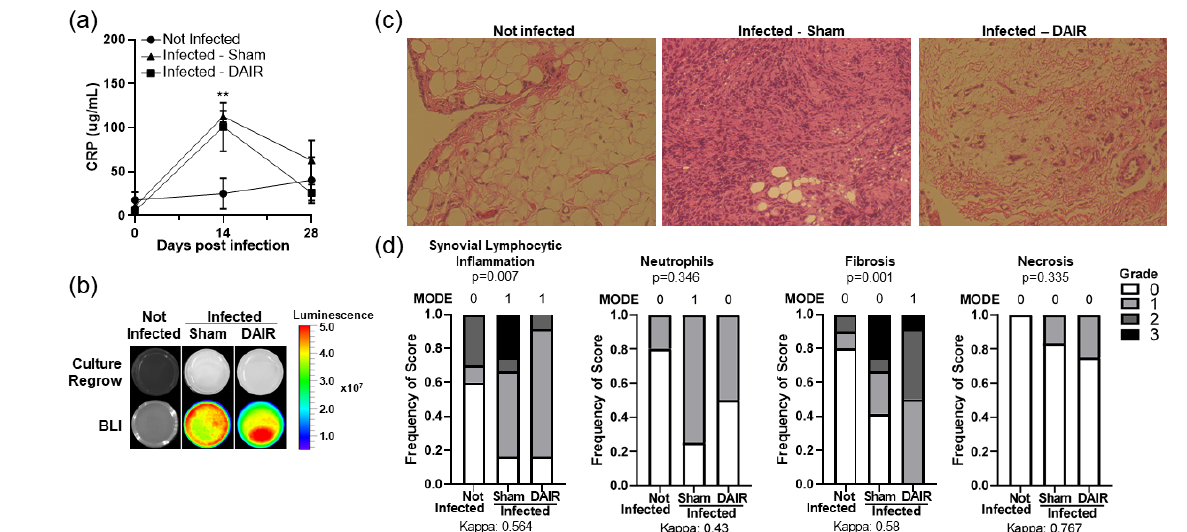
Figure 5. Panels (a–d) show readouts of bacterial infection. (a) Peripheral blood was collected as a baseline and then at 14 and 28d after infection, and it was analyzed for CRP levels by ELISA. For the baseline and 14d, n = 5–6, and for 28d, n = 3–6 for the two experimental treatments ( ∗∗ p = 0.0022 at 14d). Panel (b) shows a representative figure of 2-week culture regrowth and BLI from tissues taken 28d after infection. Panel (c) presents representative images of Harris modified H&E-stained synovium tissue from rabbits infected 28d prior. A 10 × magnification was utilized, and n = 5–6 per group for the two experiments. Panel (d) shows the scores of synovitis-related markers of inflammation from two individual blinded reviewers ( n = 5–6 per group for the two